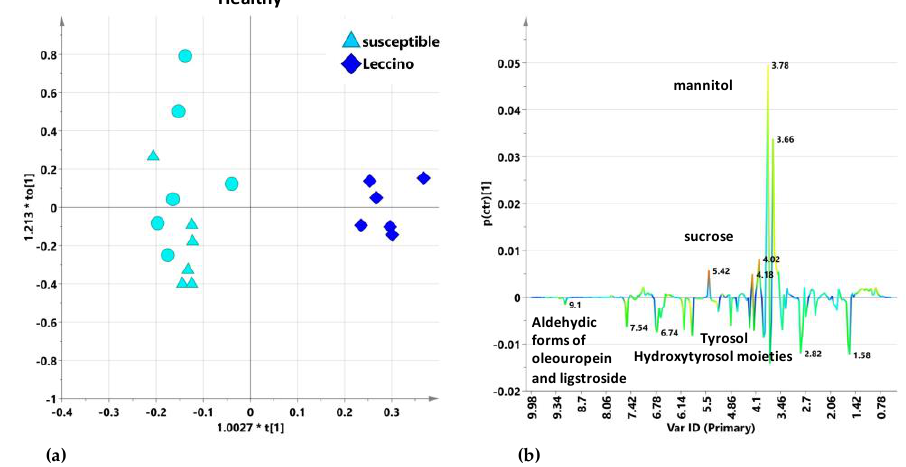
Figure 9. ( a ) OPLS-DA t[1]/t[2] scores plot for healthy Dentamet ® -treated Leccino and susceptible cultivar leaf sample. Different symbol styles for Cellina di Nardò (circles) and Ogliarola salentina (triangles) susceptible cultivars are reported. ( b ) S-line plots for the model visualizing the p(ctr)[1] loading colored according to the absolute value of the correlation loading, p(corr)[1].